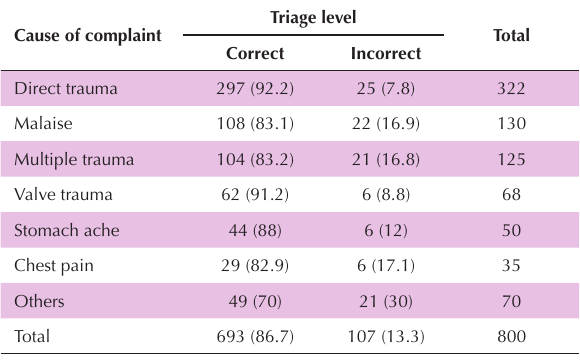
Table 3. Relationship between triage grouping and cause of complaint Cause of complaint